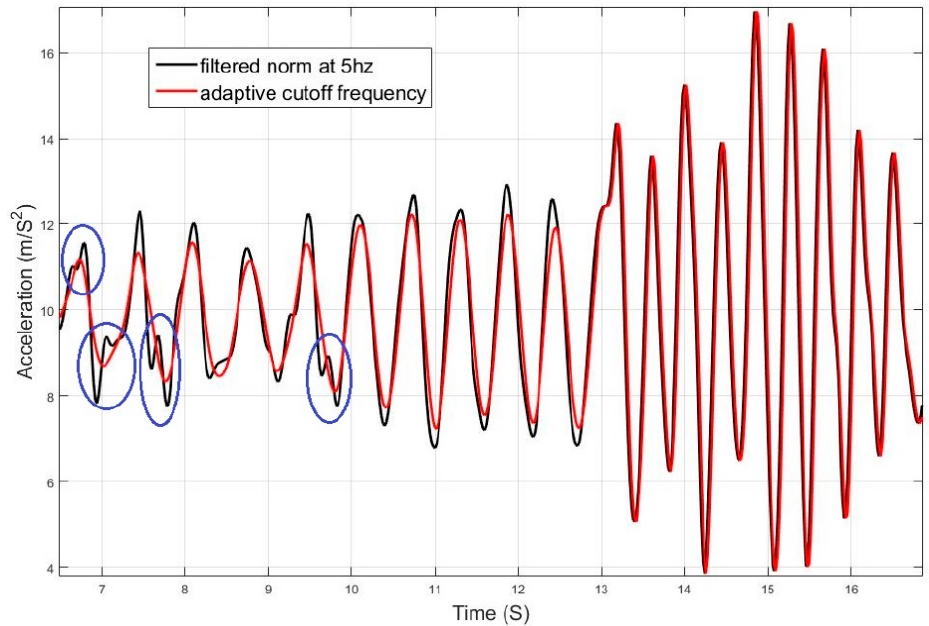
Figure 8. Effect of appropriately selecting the cut-off frequency of low-pass filter.